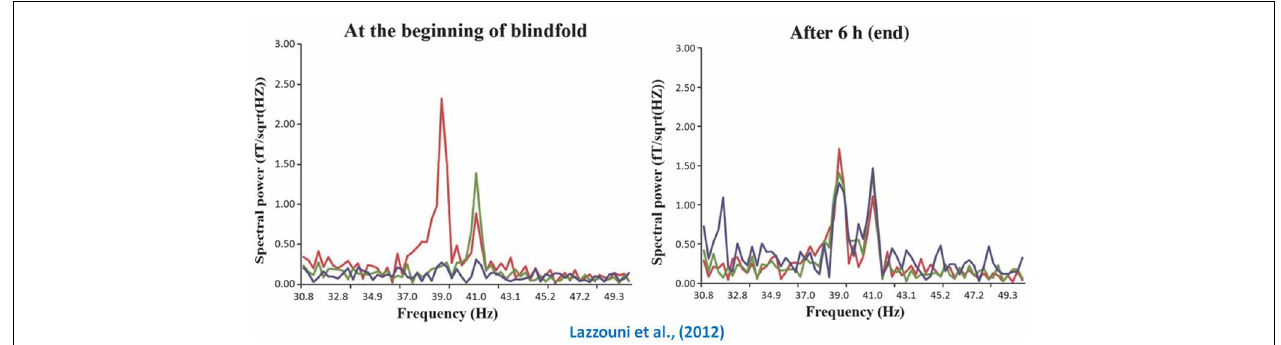
FIGURE 2 | Crossmodal plasticity in temporarily deprived sighted individuals. This figure portrays a recent MEG finding that testifies to the impressive speed at which the visual cortex can display auditory cortex-like functioning following a short period of visual deprivation. The left graph shows that prior to blindfolding the two spectral peaks (left temporal in red; right